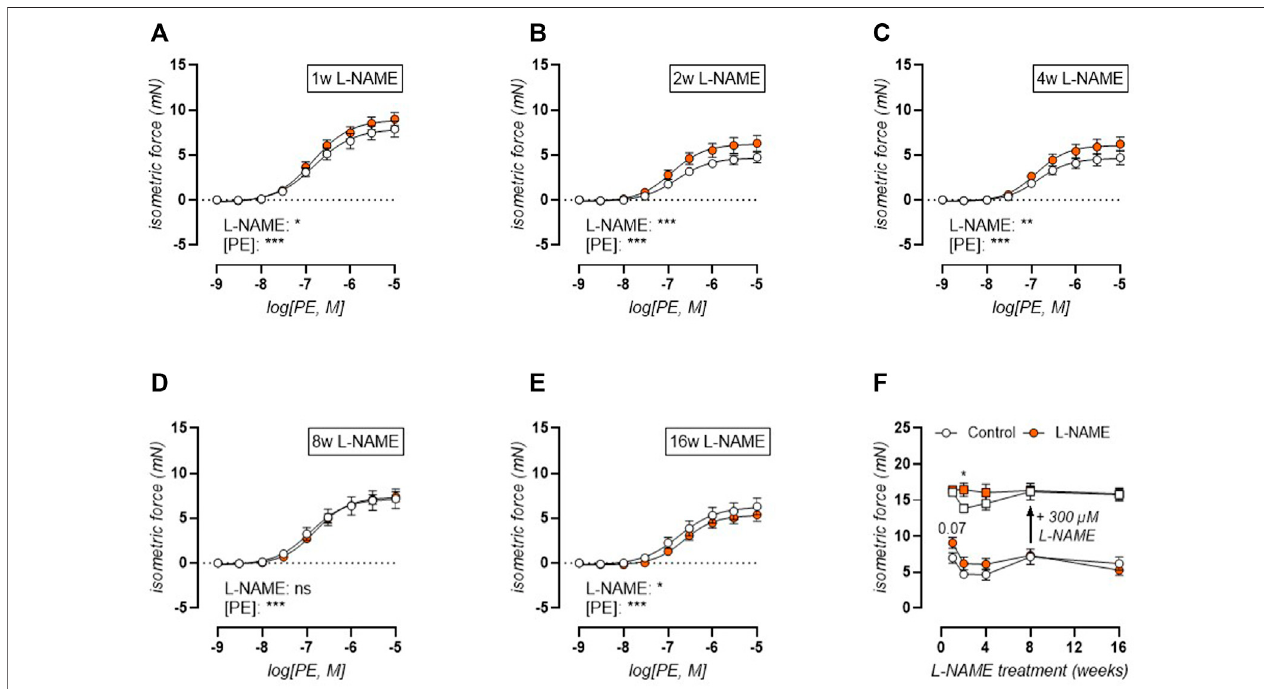
FIGURE 6 | Phenylephrine (PE) contractions are heightened in the early phase with late-term reduction. Concentration-response curves are shown for increasing treatment durations: 1 week (A) , 2 weeks (B) , 4 weeks (C) , 8 weeks (D) , and 16 weeks (E) L-NAME treated (n ≥ 7) and control (n ≥ 9) mice. Maximal effect of the non- linear regression analysis (circles, (F) ) and maximal PE-induced contractions after inhibition of basal NO production by 300 μ M L-NAME (squares, (F) ) were plotted longitudinally. Statistical analysis using two-way ANOVA ( (A-E) , overall signi fi cance: bottom) or multiple t-tests ( (F) , separate analyses for circles and squares, signi fi cance in graph). * p < 0.05, ** p < 0.01, *** p <